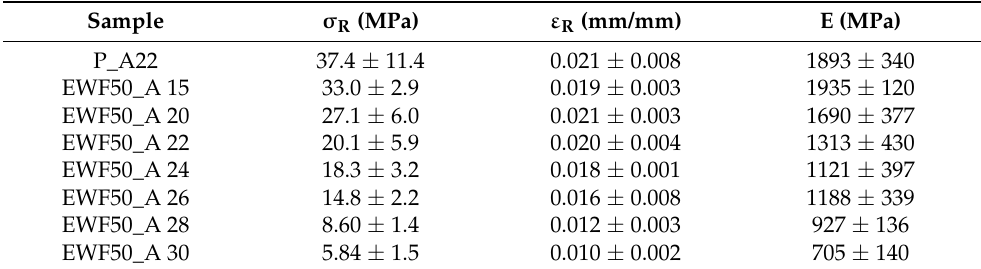
Table 5. ANOVA parameters—amount of EWF as the source of variation.